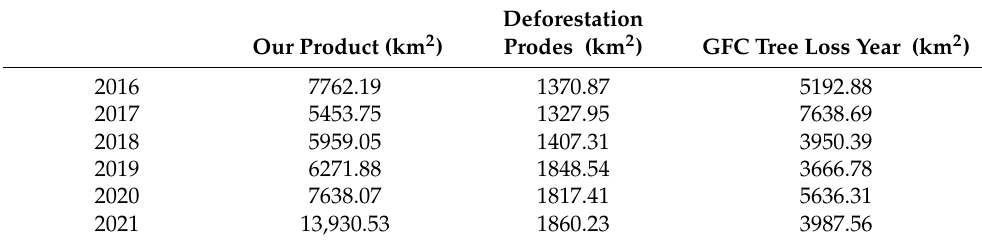
Table 2. Annual tree cover change in the Amazonian region of Mato Grosso in km 2 on the period from 2016 to 1 December 2021 obtained with our product, PRODES, data and GFC “tree loss year”